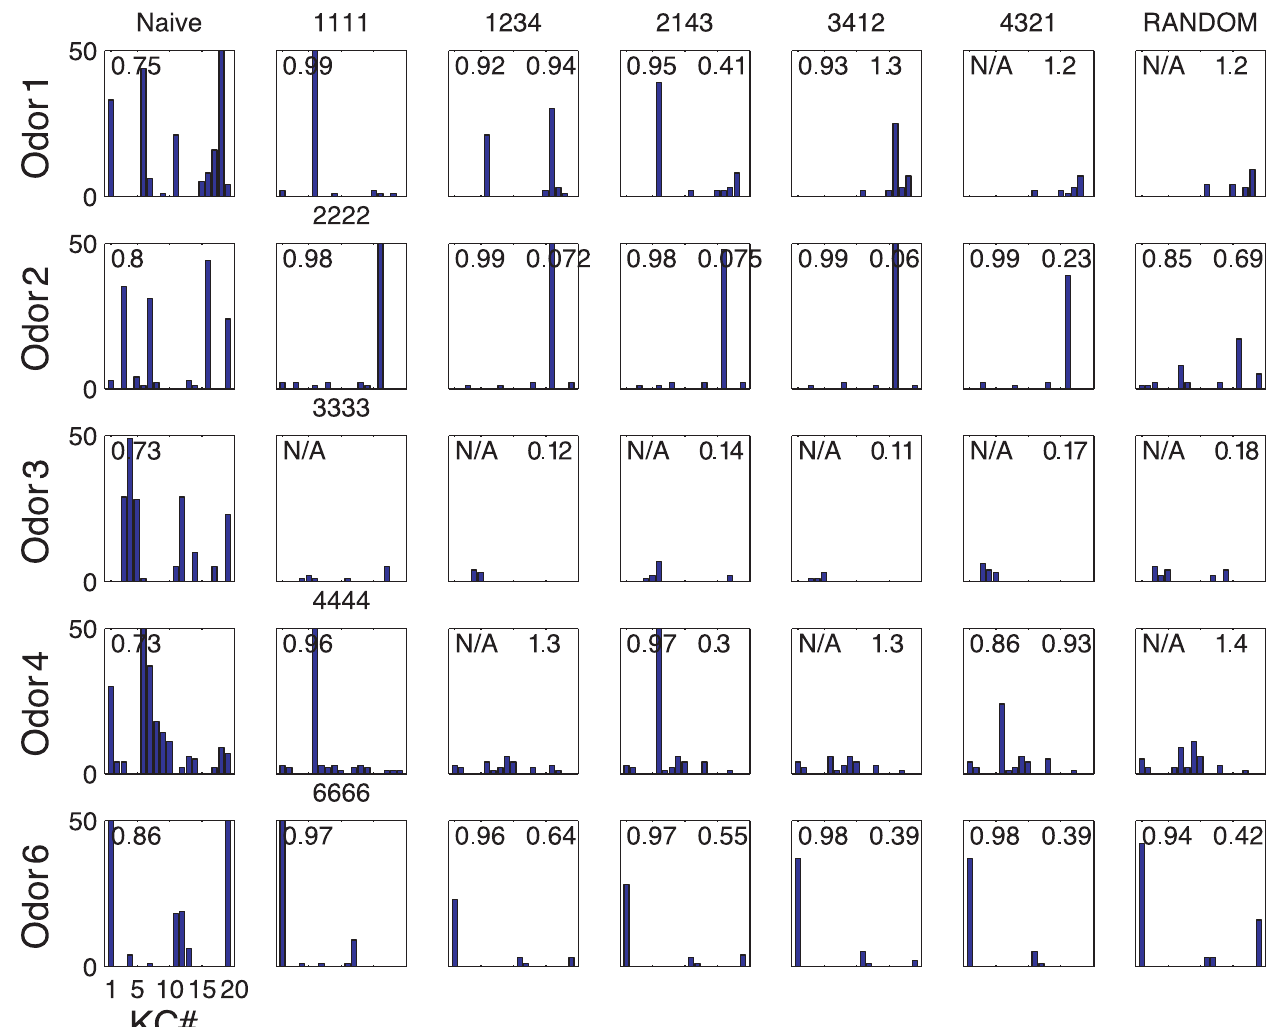
Figure 4. Synaptic tuning over a wide range of initial conductance values. (A) Left column: spike count bar plots for naive population responses (100%: reference value 170 pS; see text). Middle column: responses after SRDP-based synaptic tuning during presentation of 4 blocks of olfactory stimuli. Right column: the same for STDP. The same test odor was used in all conditions. The sparseness measure Sp for each condition is indicated in the upper left corner of the bar plots. Bottom row: Histogram of the sparseness measure at 130% of initial conductance value across 8 different odors, in the naive, SRDP, and STDP cases. Note the dramatic increase in sparseness following both synaptic plasticity mechanisms. (B) Sparseness as a function of initial synaptic conductance value in the naive, SRDP, and STDP cases. In each conductance condition the distribution of sparseness values Sp across odors is indicated as boxplots. Each box represents the lower quartile, median, and upper quartile. The whiskers extend from each end of the box for 1.5 times the interquartile range. Outliers are indicated as crosses.